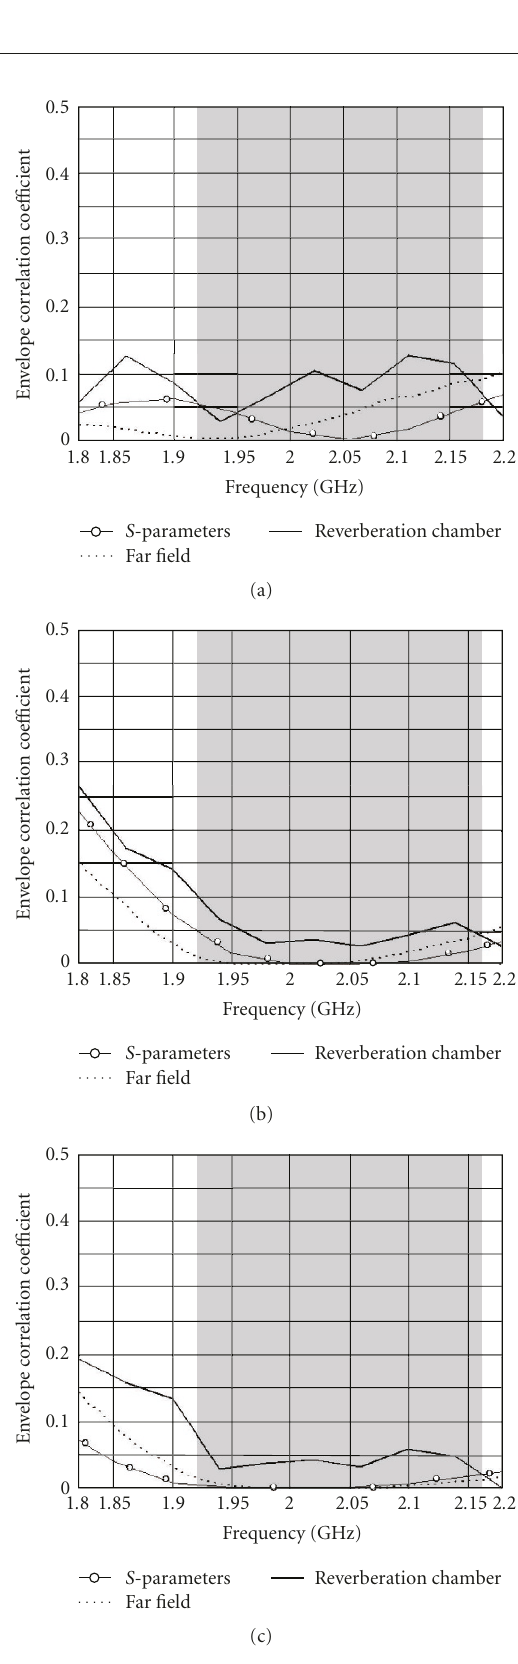
Figure 8: Envelope correlation coe ffi cient versus frequency of the two-antenna systems: (a) without the neutralization line, (b) with the line between the feeding strips, and (c) with the neutralization line between the shorting